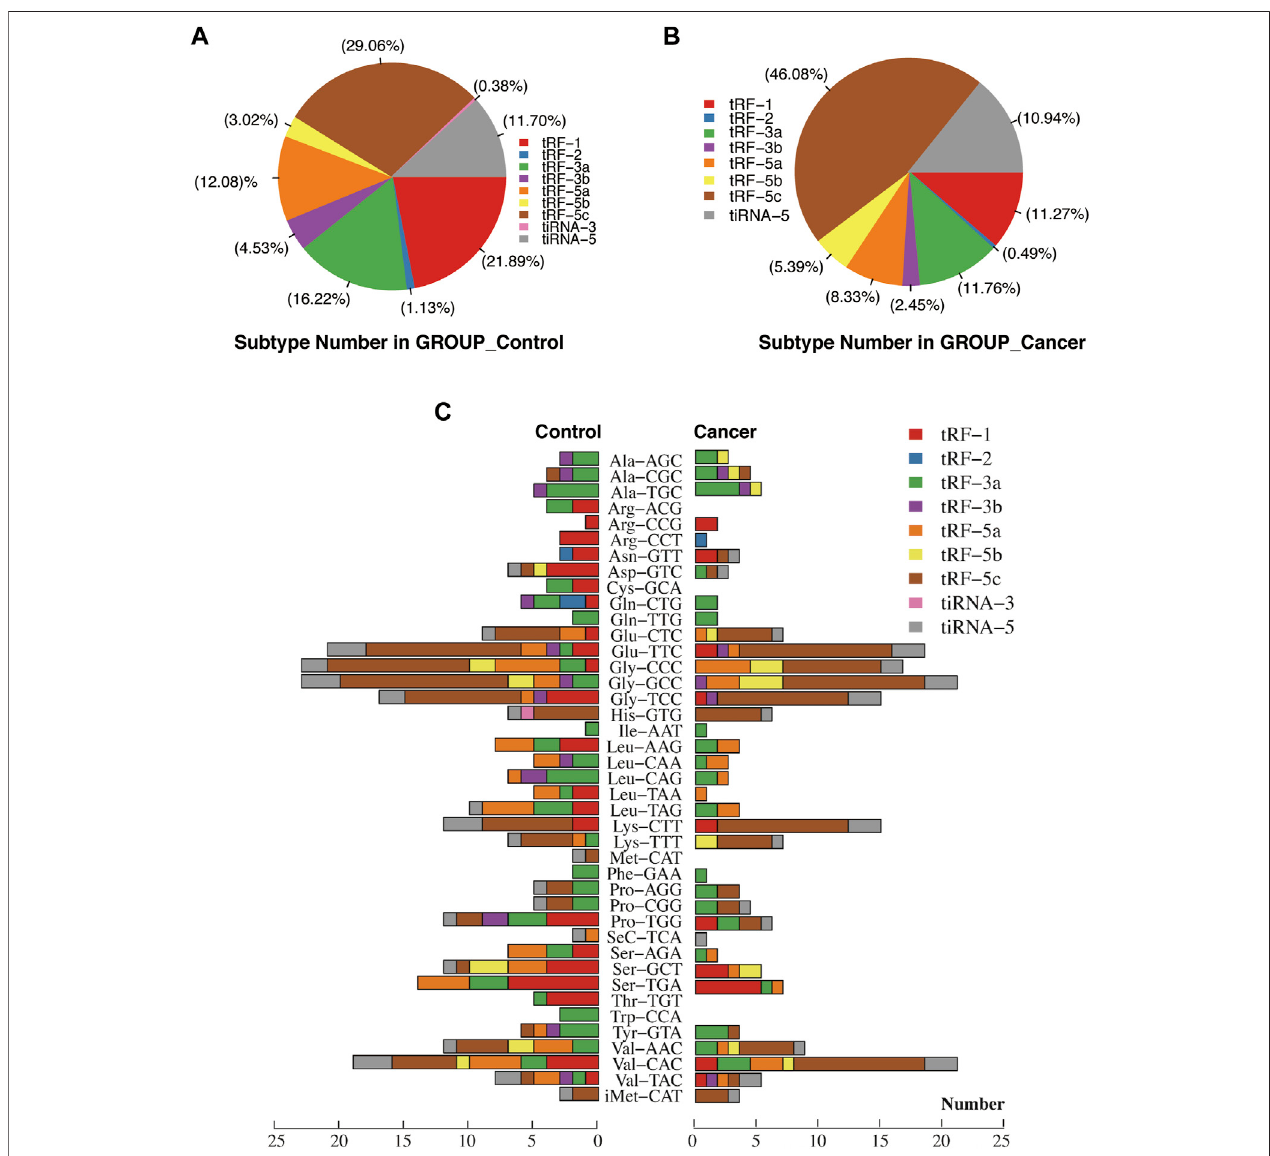
FIGURE 2 | Proportions of subtype tRFs and tiRNAs against tRNA isodecoders between healthy controls and nasopharyngeal carcinoma. (A) Proportions of tRF- 1, tRF-2, tRF-3a, tRF-3b, tRF-5a, tRF-5b, tRF-5c, tiRNA-3, and tiRNA-5 in healthy controls. (B) Proportions of tRF-1, tRF-2, tRF-3a, tRF-3b, tRF-5a, tRF-5b, tRF-5c, and tiRNA-5 in nasopharyngeal carcinoma. (C) Stacked plot for all subtypes of tsRNAs between two groups clustering by the anticodon of the tRNAs. The X -axis representsthenumberofallsubtypetsRNAsderivedfromthesameanticodontRNA,andthe Y -axisshowsthetRNAs withthesameanticodon.Thebarwithcolor representsthenumberofeachsubtypeoftsRNAs.Red,blue,green,purple,orange,yellow,andbrownrepresentthesubtypesoftRFs.Pinkandgrayrepresentthetwo subtypes of